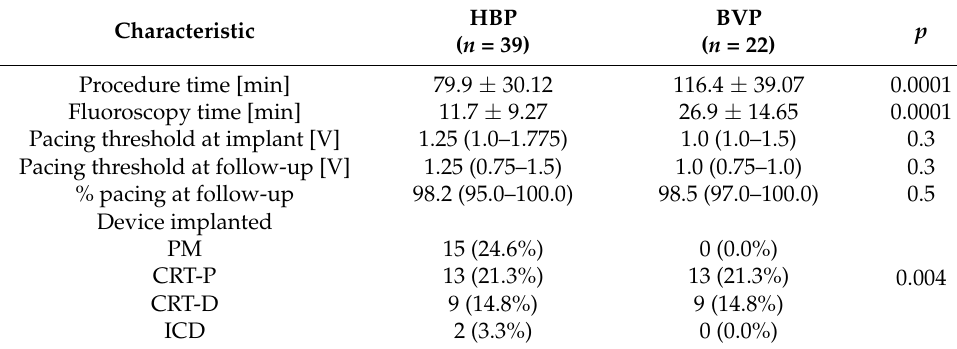
Table 2. Procedural and pacing